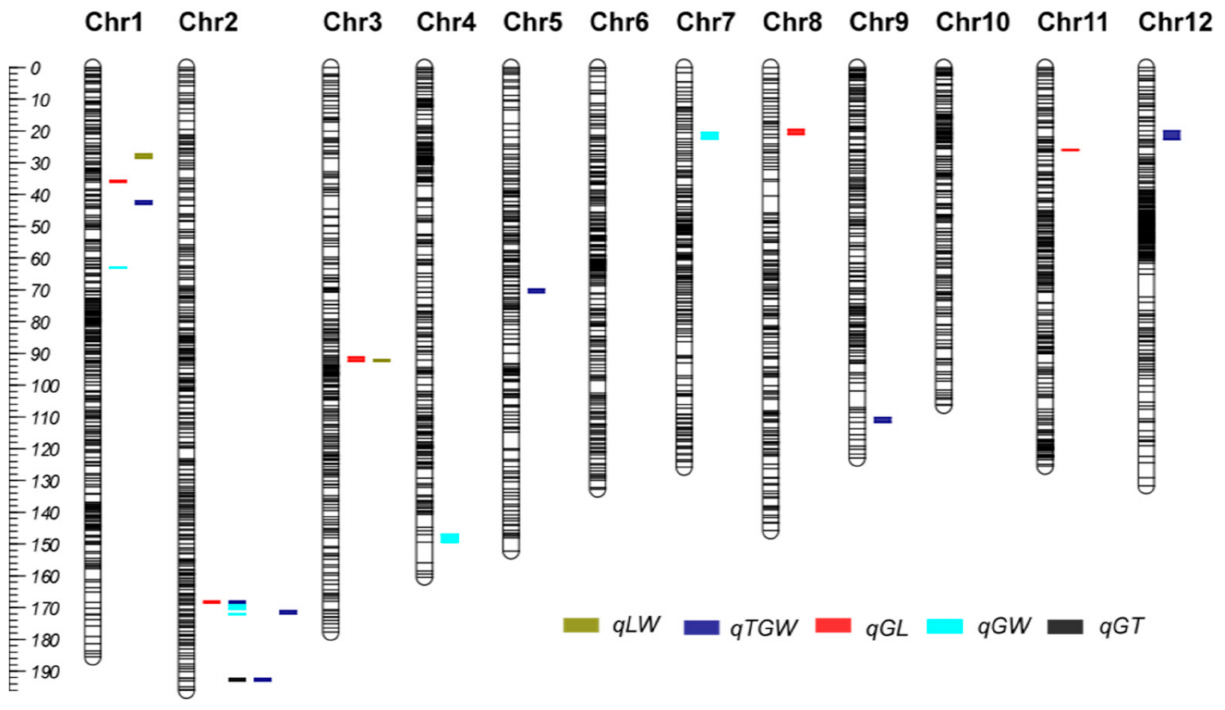
Figure 7. The position of quantitative trait loci (QTL) for grain shape and grain weight-related traits and heterosis QTL in RILs. Different colors represent the QTL detected in grain shape and grain weight. GL, grain length; GW, grain width; TGW, thousand-grain weight; LW, length to